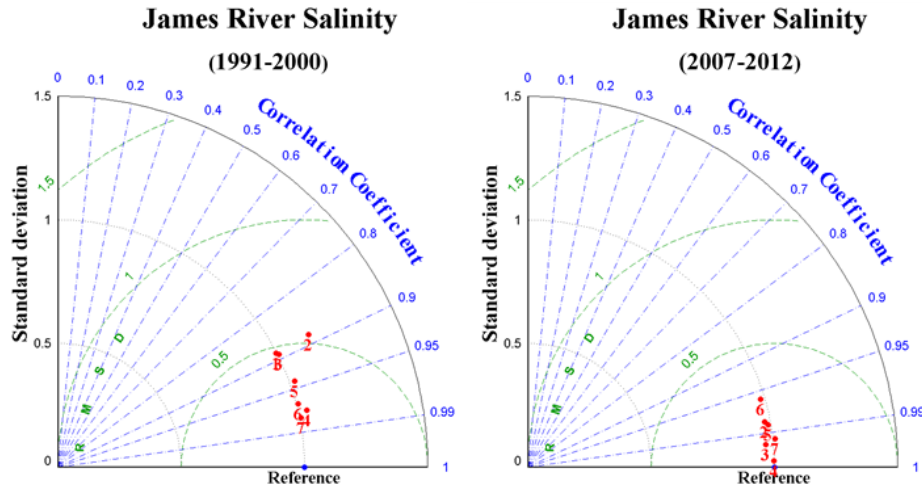
Figure 4. Taylor diagrams representing model-data comparisons at seven monitoring stations in the James River. Three axes represent correlation coefficients (blue lines), the centered root-mean-square difference (green lines) and normalized standard deviation (black lines) (station location: 1 = LE5.5, 2 = LE5.6, 3 = LE5.4, 4 = LE5.3, 5 = LE5.2, 6 = LE5.1, 7 = RET5.2, reference RMSD value = 2.39 psu).